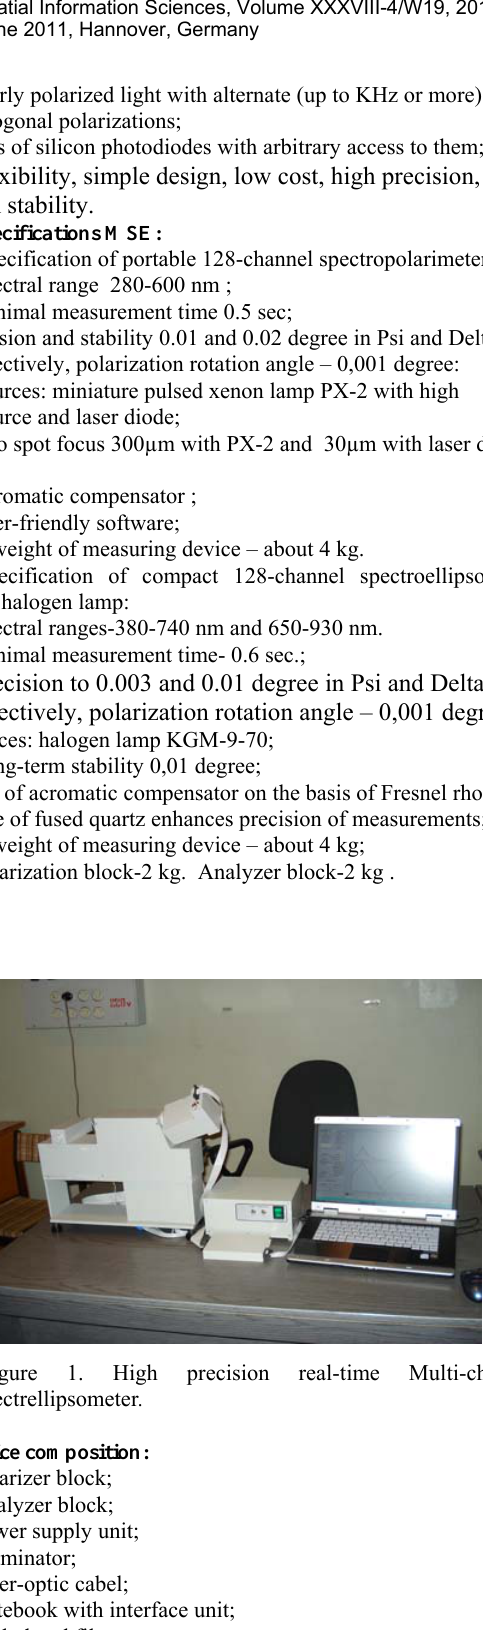
The algorithmic support of the MSP is based on a complex application of recognition and classification algorithms on the basis of 128 spectra images registered during a fixed period of time (Mkrtchyan et al., 2009; Ferdenant A. Mkrtchyan et al.,